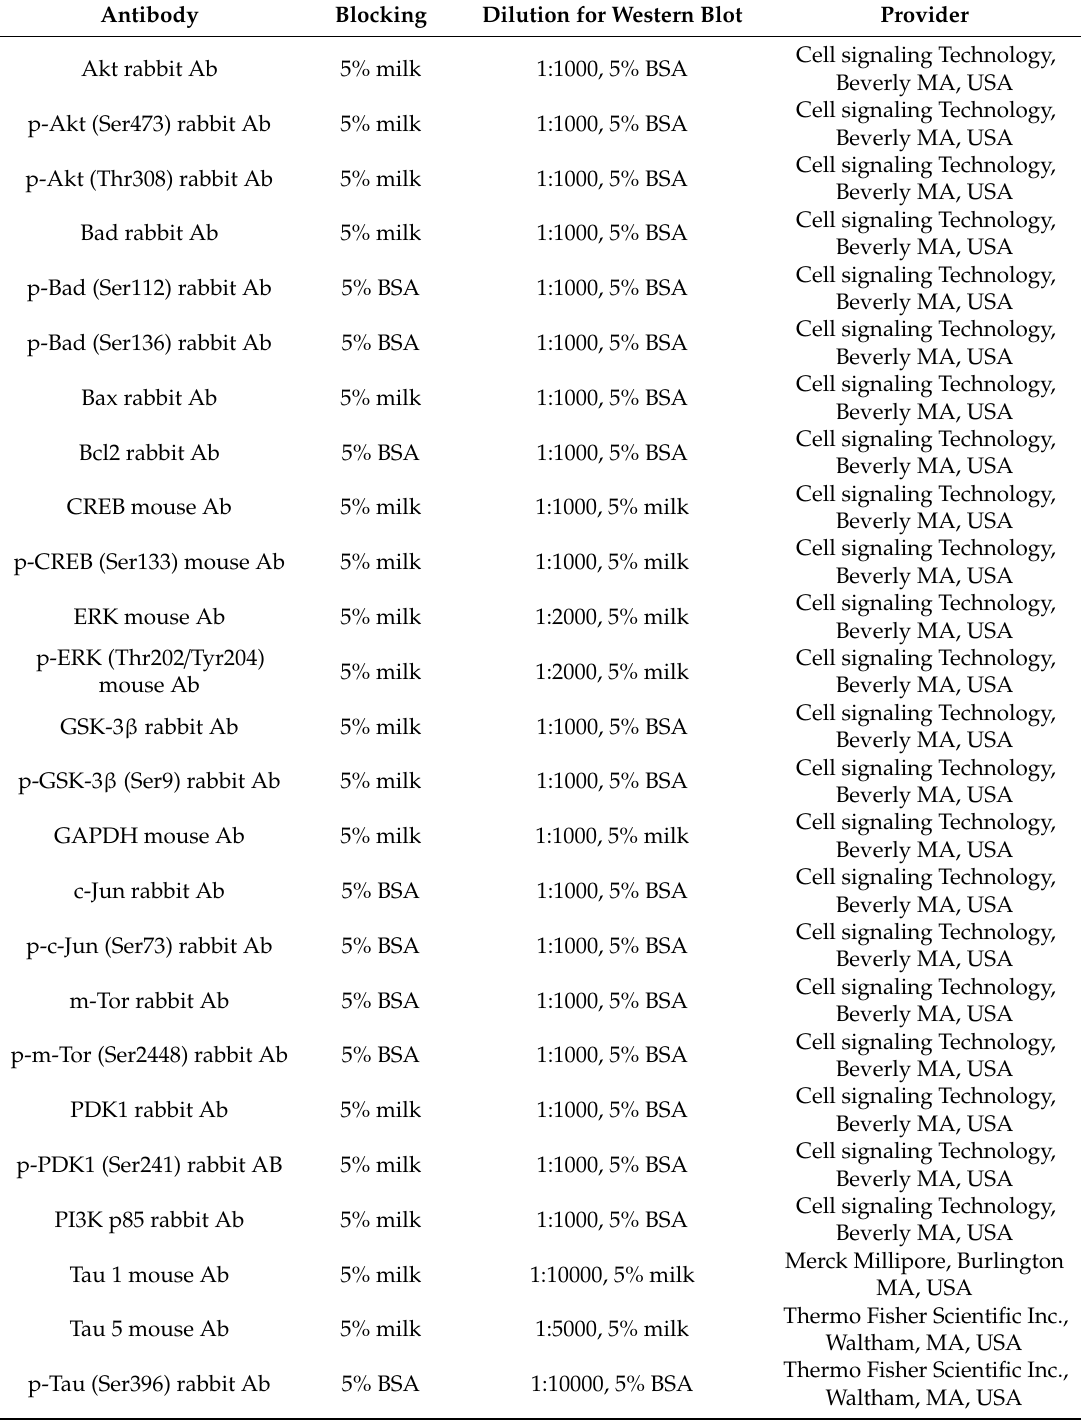
Table 2. List of primary antibodies used for immunoblotting and their